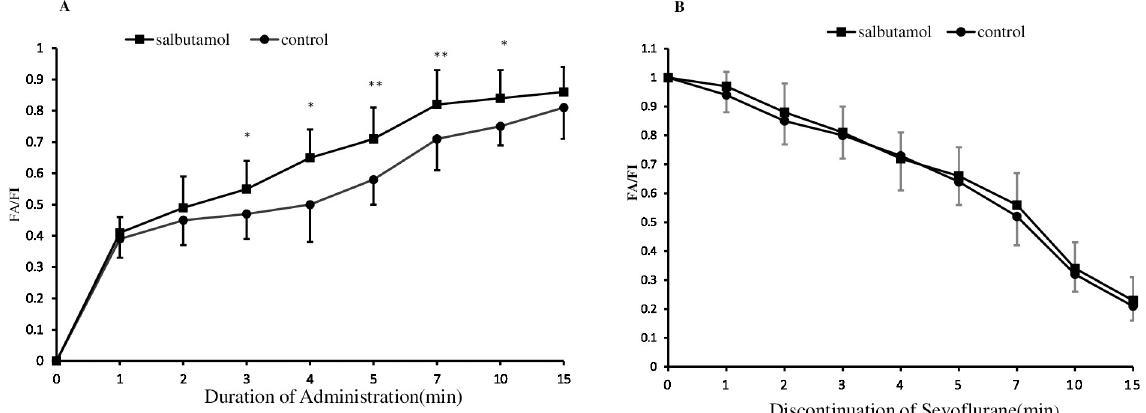
Fig 2. Wash-in and elimination curves for sevoflurane. (A) The wash-in profiles for sevoflurane in the salbutamol and control groups after opening the vaporizer (F A /F I represents the fraction of end-tidal anesthetic concentration [F A ] to the inspired sevoflurane concentration [F I ]). (B) The elimination curves for sevoflurane in the salbutamol and control groups after discontinuation 15 min before the end of surgery (F A /F I represents the ratio of the end-tidal sevoflurane concentration [F A ] to the F A immediately before the beginning of elimination [F A0 ]). � p < 0.05, �� p < 0.01 vs. the control group. p-values were calculated using repeated measurement ANOVA followed by the Holm-Sidak post hoc